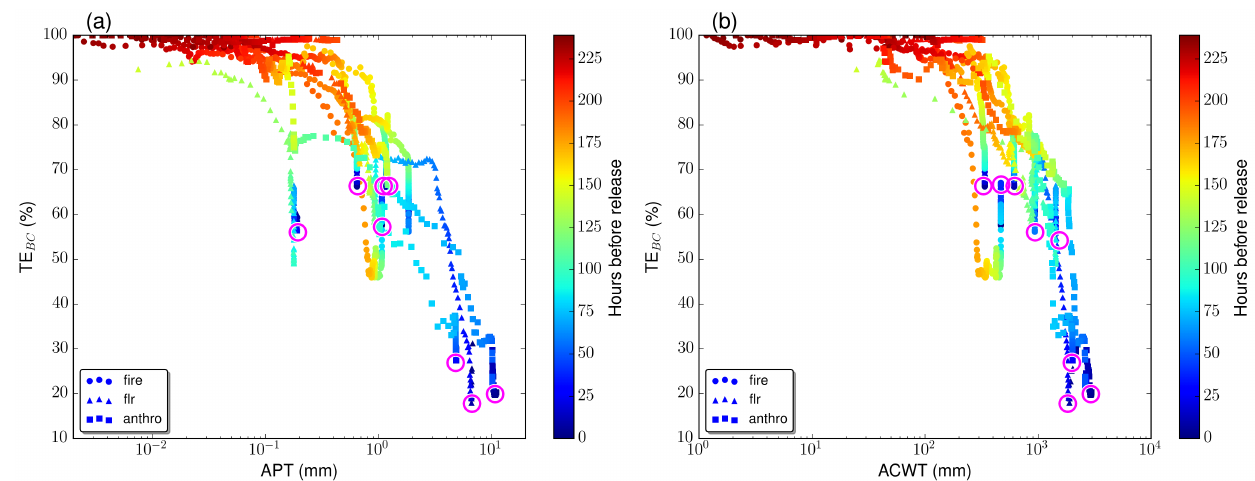
Figure 13. Transport efficiency of BC (TE BC ) for eight plumes identified from sampled air parcels by the Falcon (four boreal fire plumes, two plumes from flaring activities in northern Russia and two anthropogenic plumes from Europe) as a function of (a) the accumulated precipitation along trajectory (APT) and (b) the accumulated condensed water along trajectory (ACWT). The points are colored by the time (in hours) before the release of the trajectories in FLEXPART-WRF. Magenta circles emphasize the starting points (release time = 0) of the eight air masses discussed in Sect.